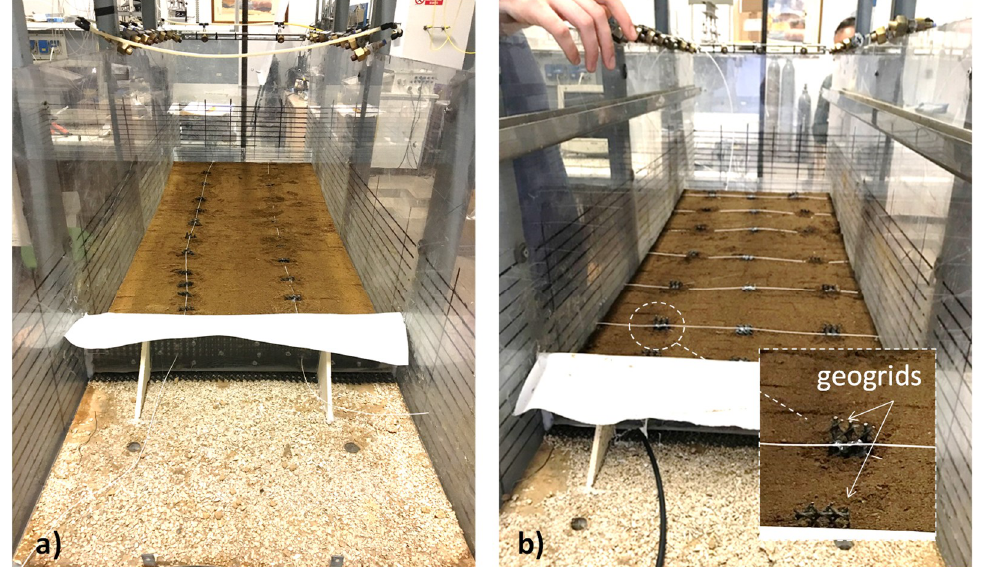
Figure 2. Fiber installation in experiments RP2 ( a ) and RP3 ( b ).